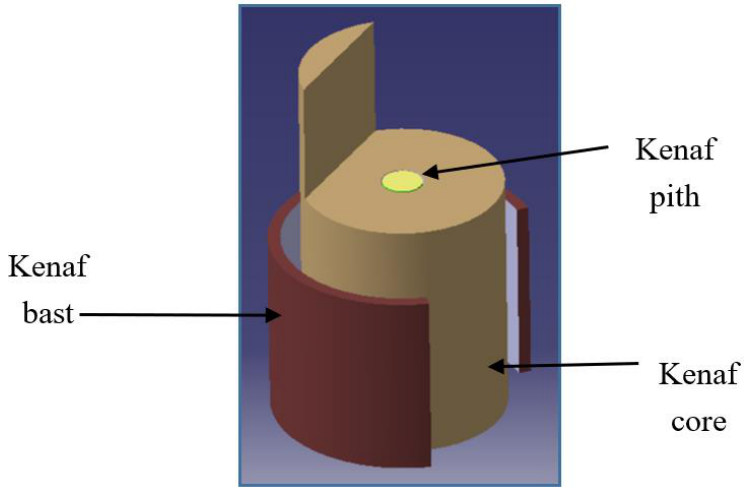
Figure 1. The illustration of kenaf stem.